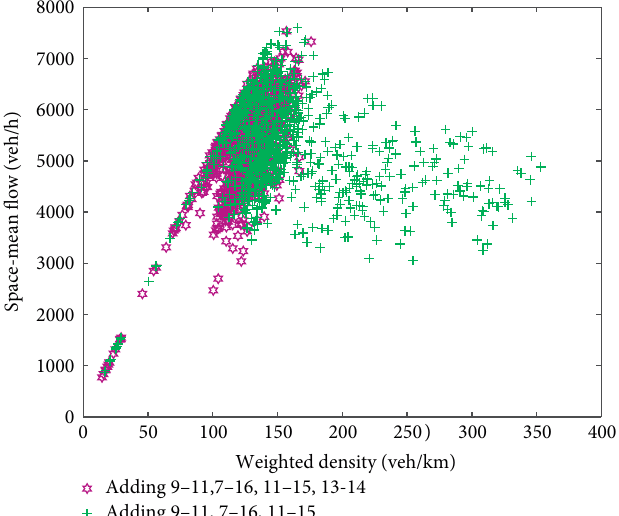
Figure 9: MFD comparison between the extended network adding link pairs (7–16, 9–11,11–15) and extended network adding link pairs (7–16, 9–11, 11–15,